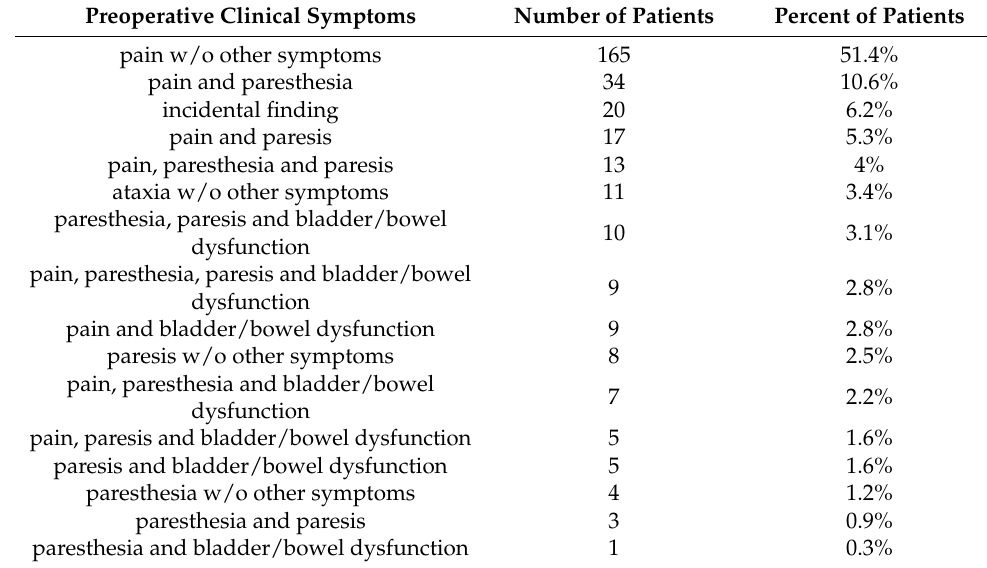
Table 2. Preopeative clinical symptoms. w/o =